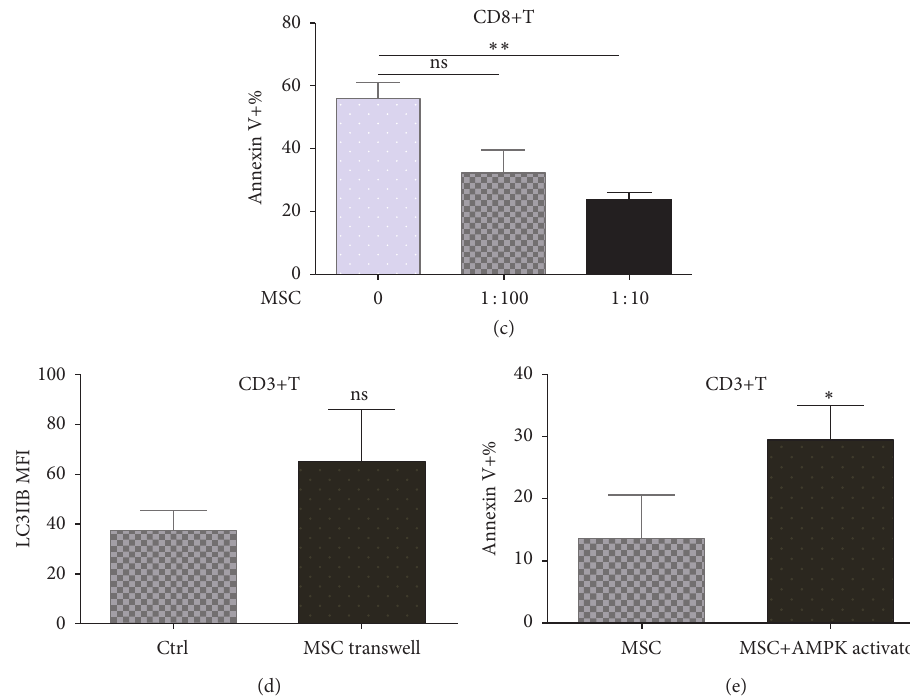
Figure 6: UC-MSCs rescued T cells from apoptosis by inhibiting autophagy activation of T cells in cell contact-dependent way. PBMCs from SLE patients were cultured with or without UC-MSCs (UC-MSCs: T = 1: 100 or 1: 10) and stimulated with anti-CD3/CD28 antibodies (3 𝜇 g/mL) for 3 days. All experiments were performed in triplicate. (a) Representatives of UC-MSCs’ inhibition on autophagy of CD3+T cells, CD4+T cells, and CD8+T cells, respectively. (b) UC-MSCs inhibited autophagy of CD3+T, CD4+T, and CD8+T cells dose-dependently ( 𝑛 = 7 ). (c) UC-MSCs suppressed T cell apoptosis in a dose-dependent way ( 𝑛 = 7 ). (d) Coculture with UC-MSCs via transwell could not inhibit T cell autophagy ( 𝑛 = 3 ). (e) Treatment of T cells with AMP-activated protein kinase (AMPK) activator abrogated UC-MSCs’ inhibition on T cell apoptosis ( 𝑛 = 3 ). ns, not significant; ∗ 𝑝 < 0.05 ; ∗∗ 𝑝 < 0.01 ; ∗∗∗ 𝑝 < 0.001